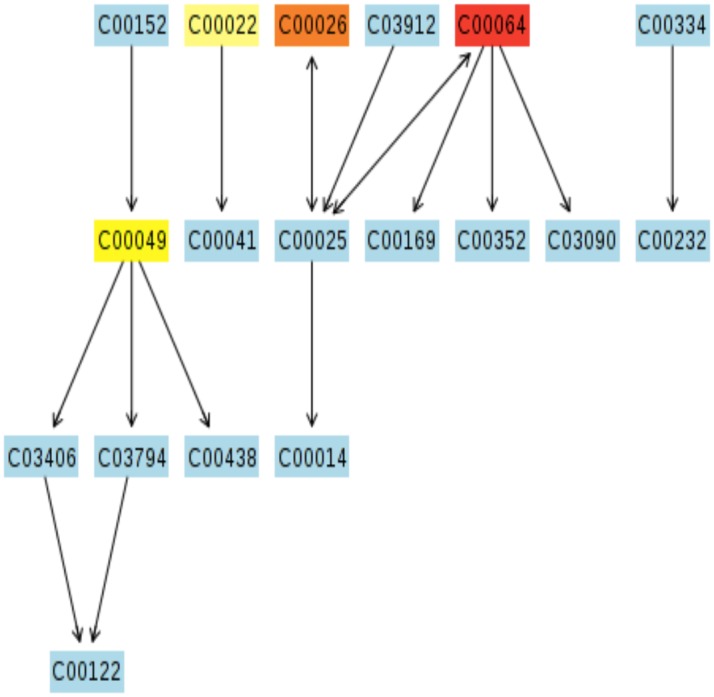
Putative metabolic pathways associated with the wound environment of chronic pressure ulcers.Significantly contributing pathway nodes include alanine, aspartate, and glutamate metabolism. Highlighted metabolites indicated hits from the metabolic profiling and are coded according to p-value. Pathway maps are generated using the KEGG reference map (http://www.kegg.jp/kegg/pathway.html).